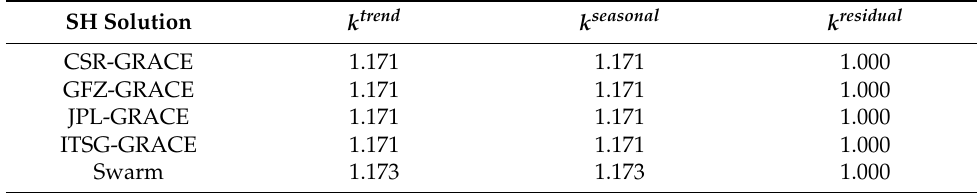
Table 2. The scale factors of four GRACE SH solutions and one Swarm solution. SH